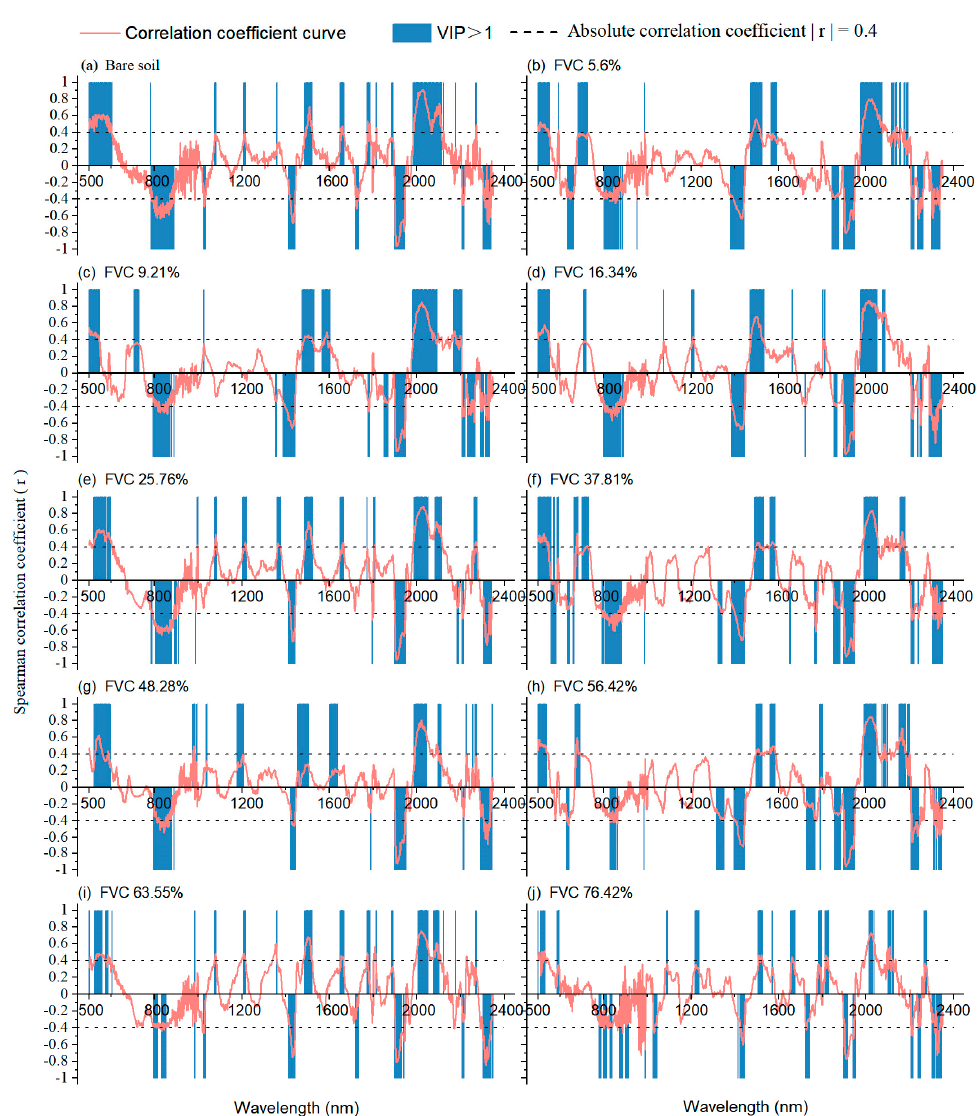
Figure 7. VIP scores in PLSR modeling (VIP > 1 is marked in gray) and Spearman correlation coefficient ( p < 0.01) between SSC and mixed